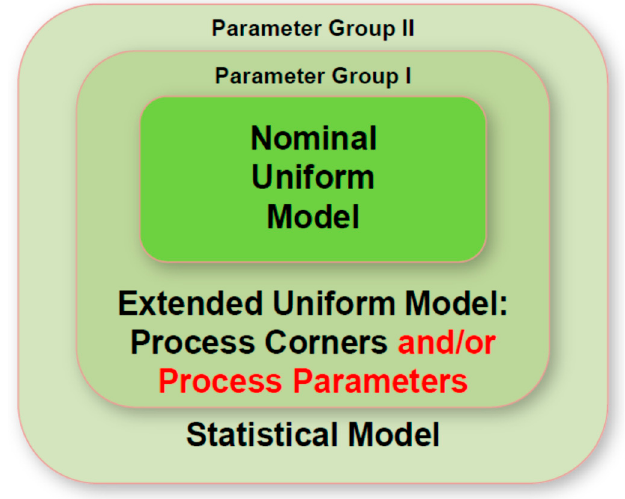
Figure 13. Extraction and generation of hierarchical compact model aware of systematic and statistical process variations.